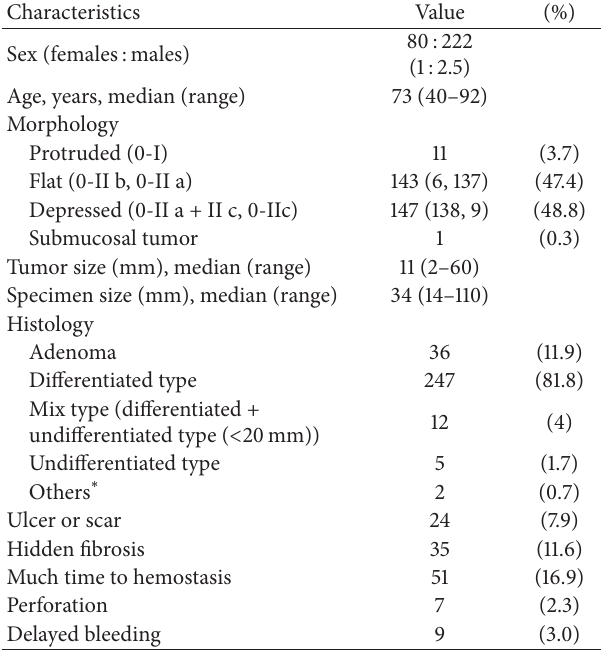
Table 1: Baseline characteristics of gastric tumors.